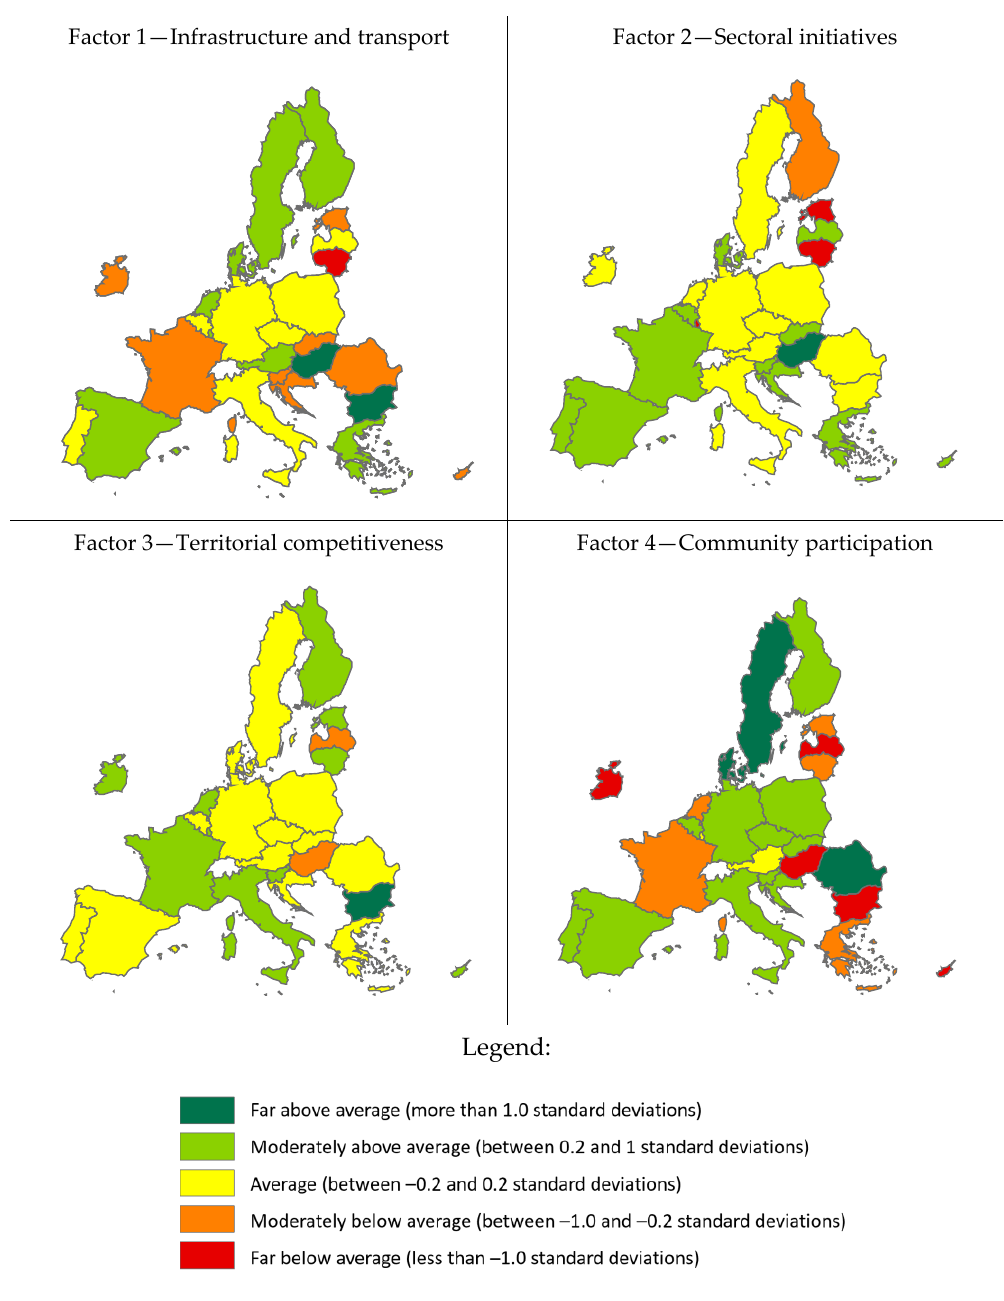
Figure 9. Geographic representation of the scores of the factors.